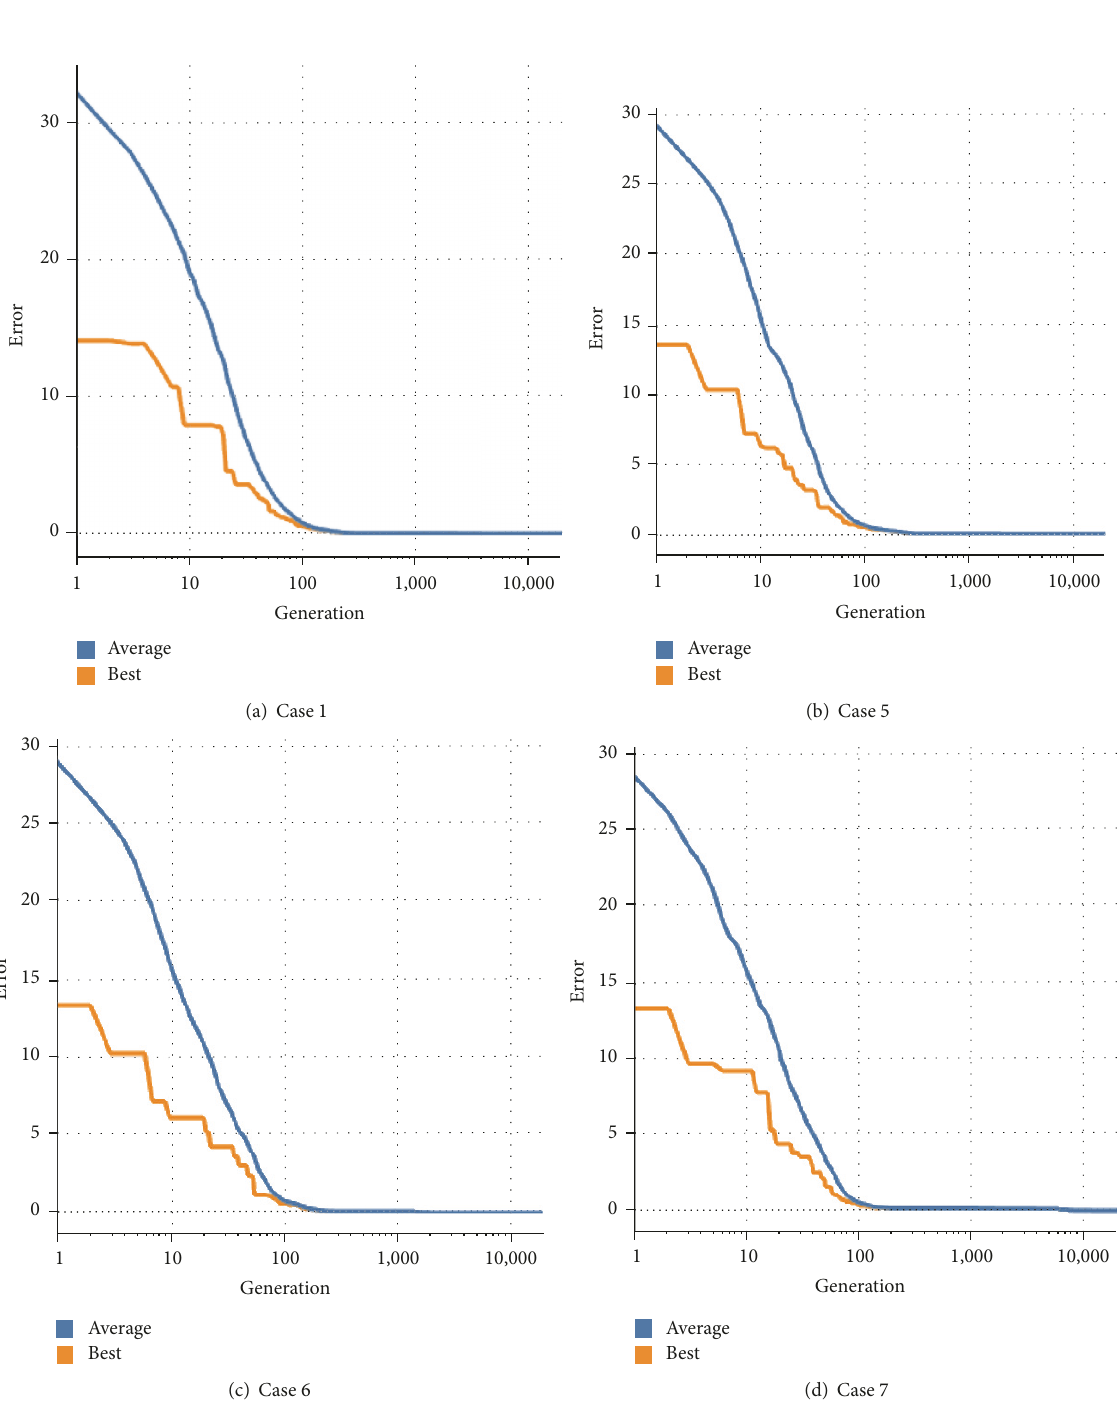
Figure 7: Line graph of showing prediction errors over the number of generations in DE on four test cases.